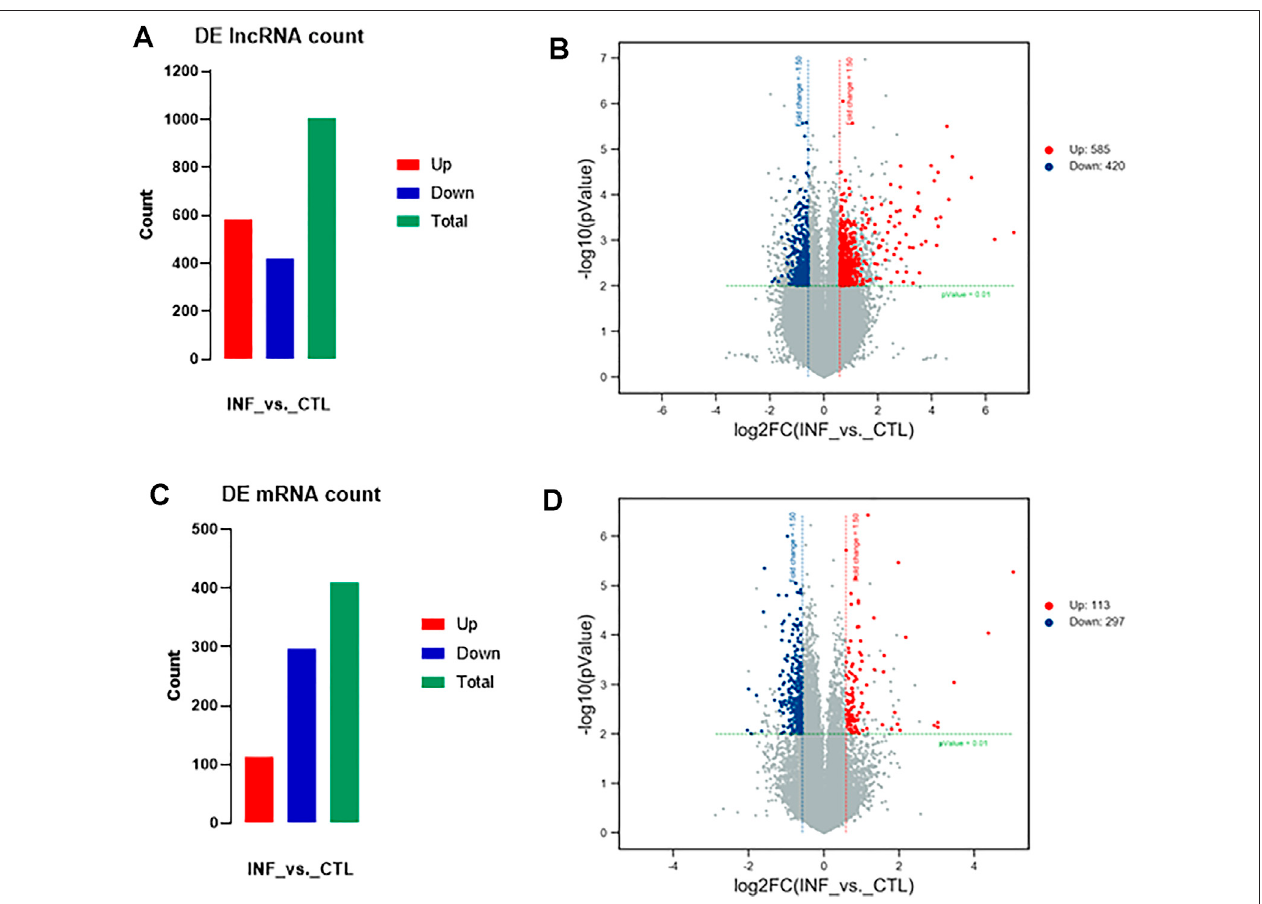
FIGURE 2 | Variation in lncRNAs and mRNAs expression in persistent chlamydial infection. (A) Summarizes the lncRNAs that were differentially expressed. In total of 1005 differentially expressed lncRNAs, 585 were upregulated and 420 were downregulated. (B) Volcano plot of up- and downregulated lncRNAs mapped via log_2 (fold change). (C) Summarizes the mRNAs that were differentially expressed. In total of 410 differentially expressed mRNAs, 113 were upregulated and 297 were downregulated. (D) Volcano plot of up- and downregulated mRNAs mapped via log 2 ( foldchange ) .